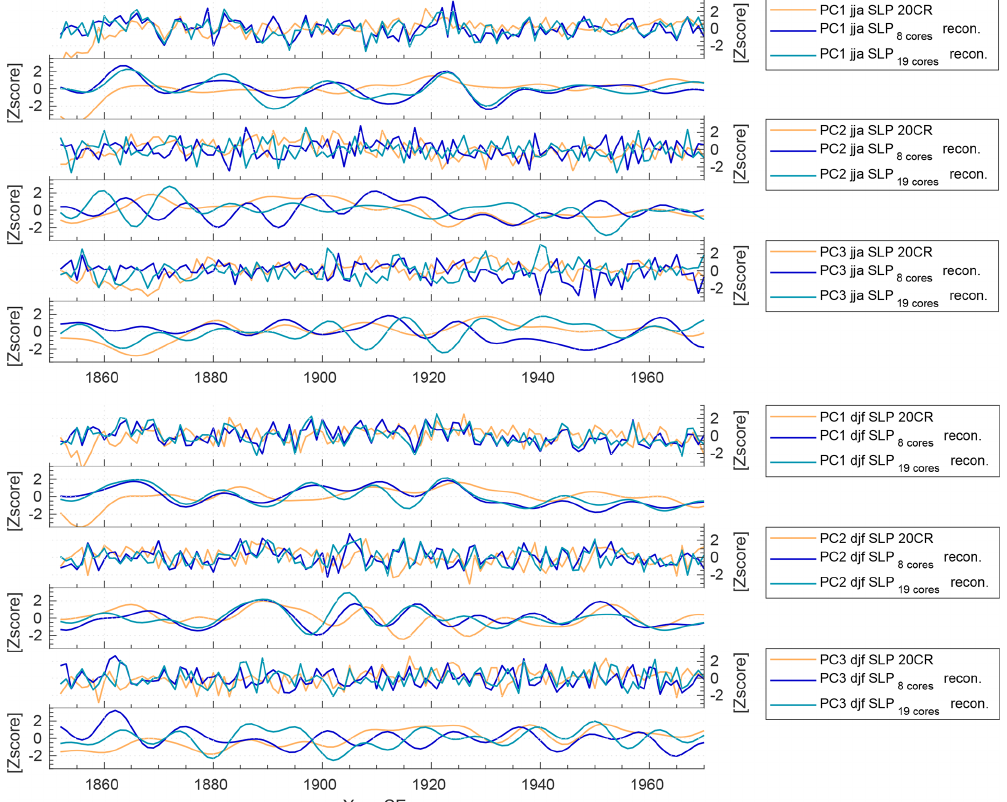
Figure 7. Time series of reconstructed PC1, PC2 and PC3 of SLP using eight ice cores (dark blue) and 19 ice cores (light blue) compared to PC1, PC2 and PC3 of 20CR SLP (yellow). Smoothed curves are using a decadal FFT filter. Top six plots are for JJA, and bottom six plots are for